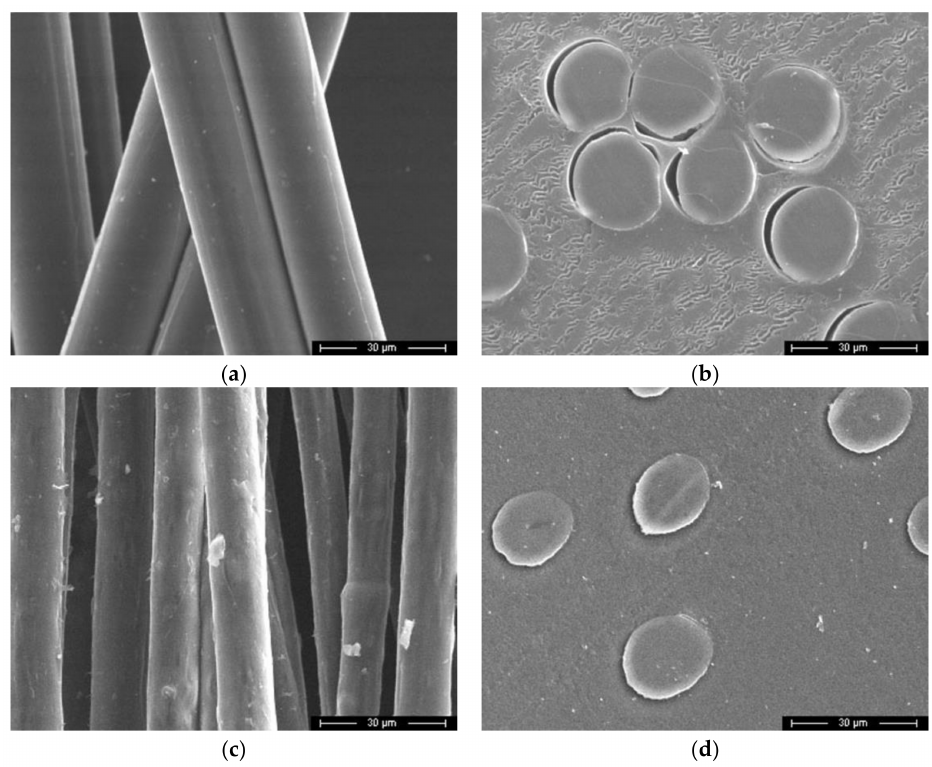
Figure 5. Micrographs of cellulose ( a , b ) and composite fibers ( c , d ) containing 95% cellulose and 5% betulin, surface ( a , c ) and cross sections ( b , d ).